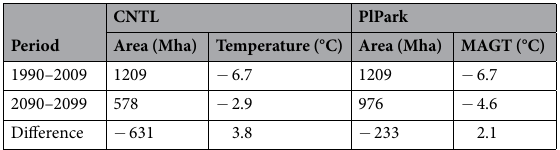
Table 1. CNTL and PlPark model experiment results of permafrost extent (Mha) and mean annual ground temperature (MAGT, 4–10 m average, in